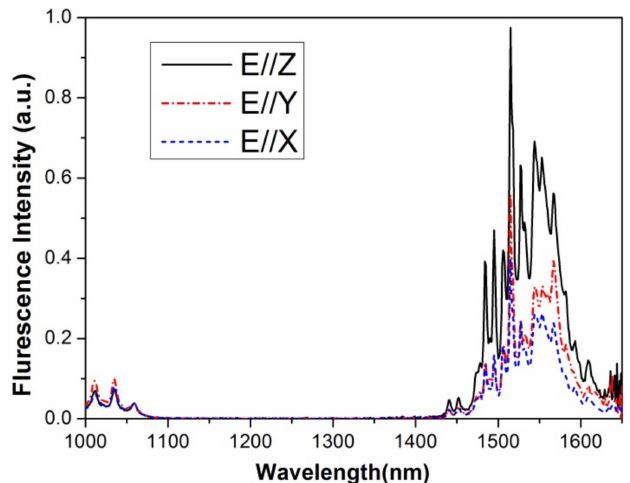
Figure 6. Polarized luminescence spectra of Er:Yb:GMB crystal at room temperature.